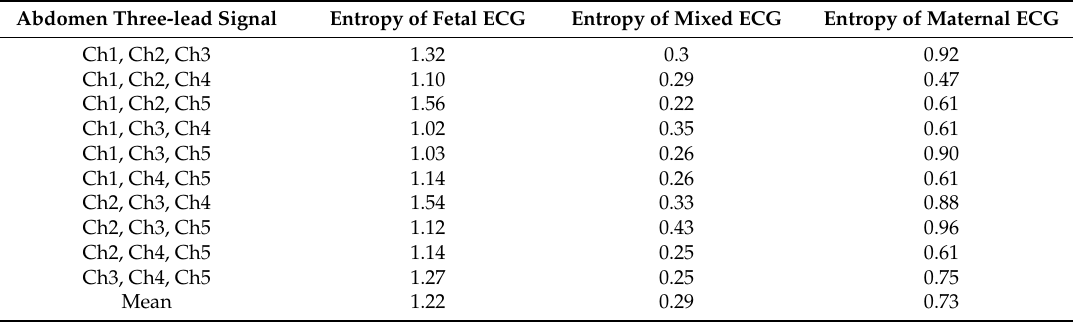
Table 2. Sample entropy